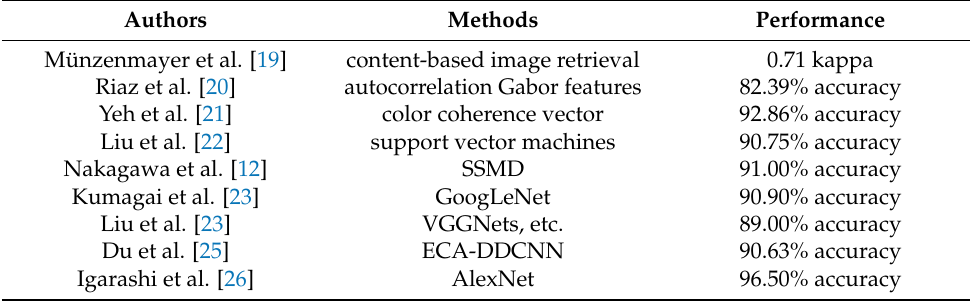
Table 1. Comparison of the methods for esophageal lesion